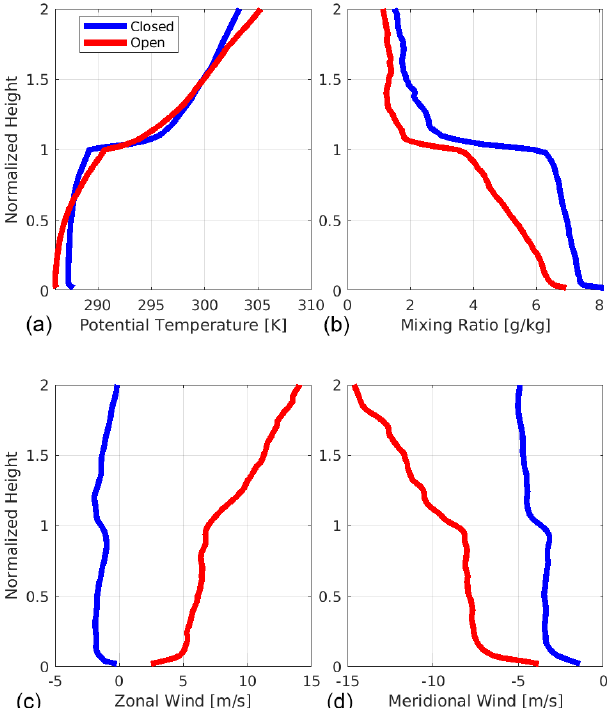
Figure 6. Comparison of composite profiles of radiosonde reported (a, b) potential temperature (K) and (c, d) water vapor mixing ratio (gkg − 1 ) for closed cell (a, c) and open cell (b, d) at 11:00UTC (blue) and 23:00UTC (red). The height coordinate is normalized by the boundary layer